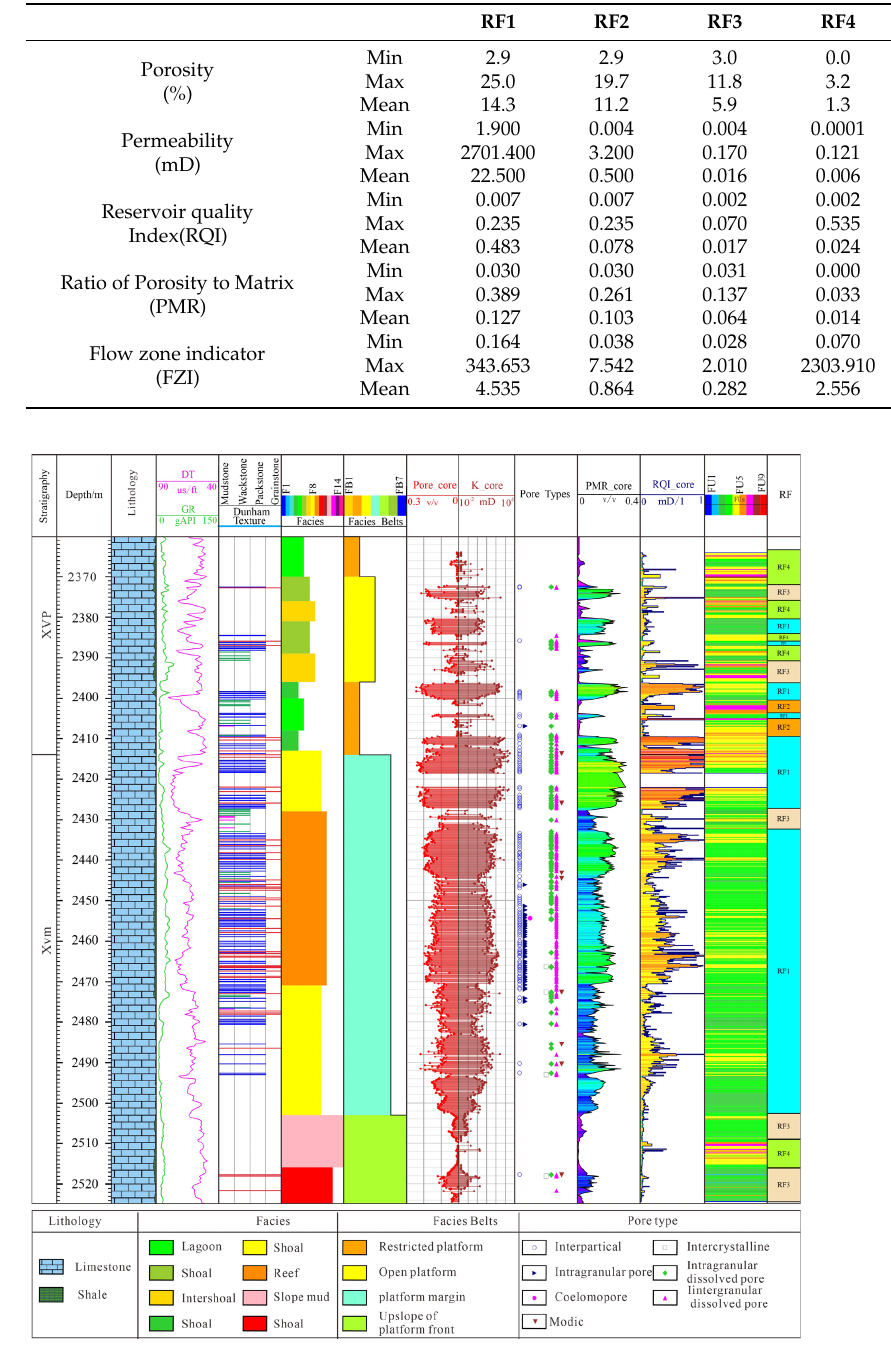
Figure 11. Correlation between different parameters including depositional, diagenetic, porosity, permeability, and flow units in the Callovian-Oxfordian stage of well S1.